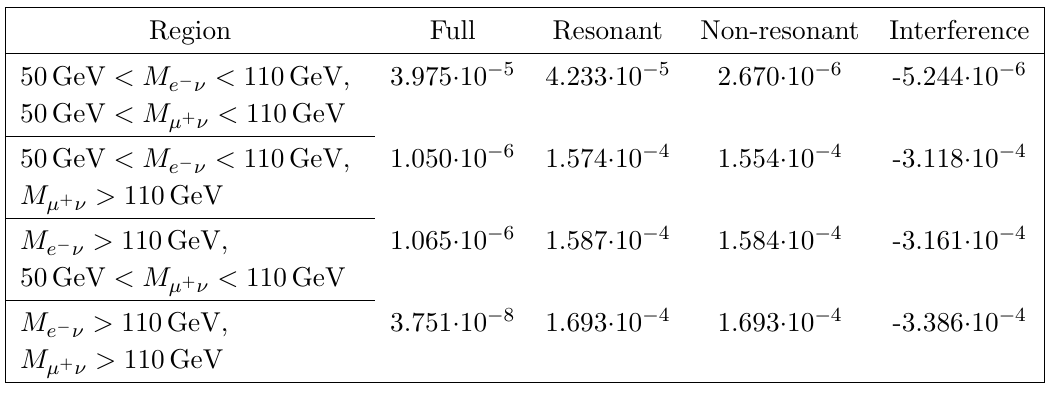
; M regions, for M ww > 1400 GeV. e (cid:0) (cid:23) (cid:22) + (cid:23)